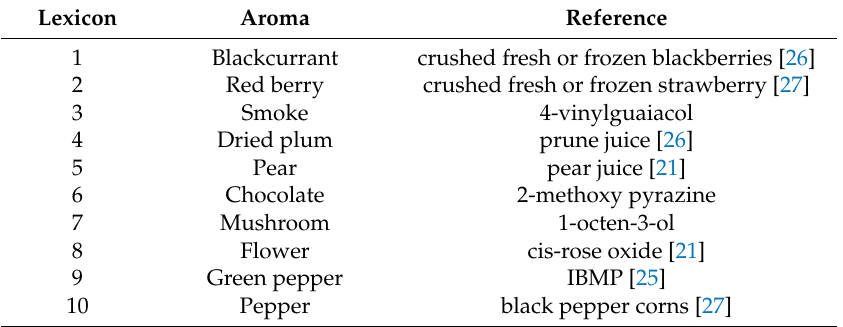
Table 5. Cabernet Sauvignon sensory reference standards used in trained panel evaluations. Lexicon Aroma Reference